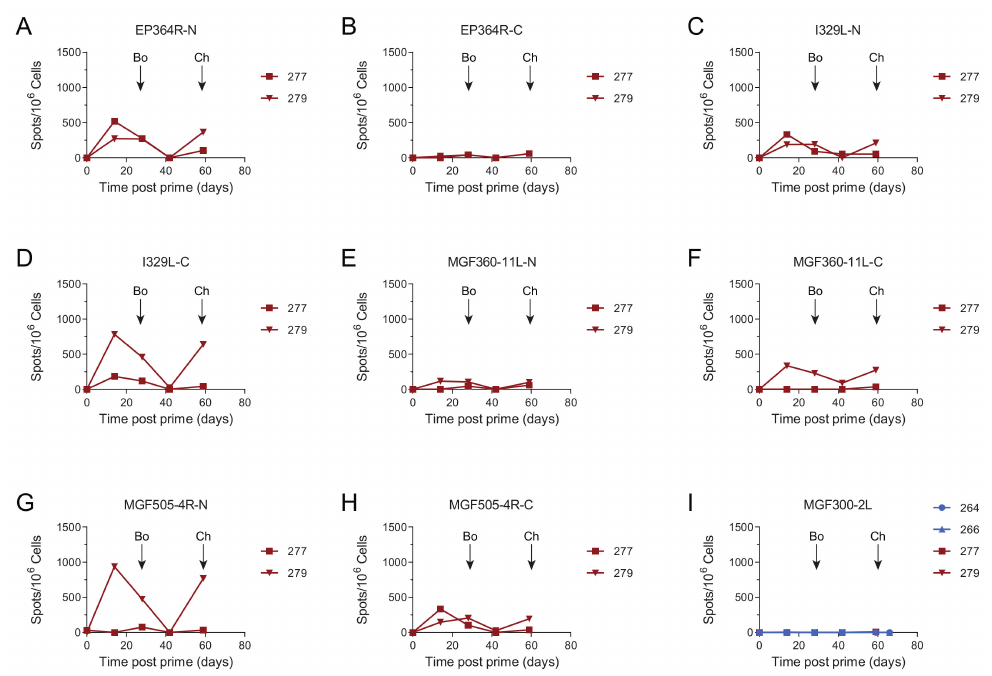
Figure 3. Antigen-specific IFN γ responses to Antigen Pool A ( I , blue) or Antigen Pool B ( A – I , red). Numbers of IFN γ -producing PBMC stimulated by pools of peptides were enumerated by ELIspot on the indicated days post-prime. N, mid and C indicate pools of peptides that correspond to the N-terminus, mid-section or C-terminus of the proteins encoded by EP364R, I329L, MGF360-11L and MGF505-4R . The response to MGF300-2L , an ASFV gene that was not part of either pool is also shown. Data points indicate the number of spots per million cells induced by the pool of peptides after background subtraction. Timing of boost (Bo) and challenge (Ch) are